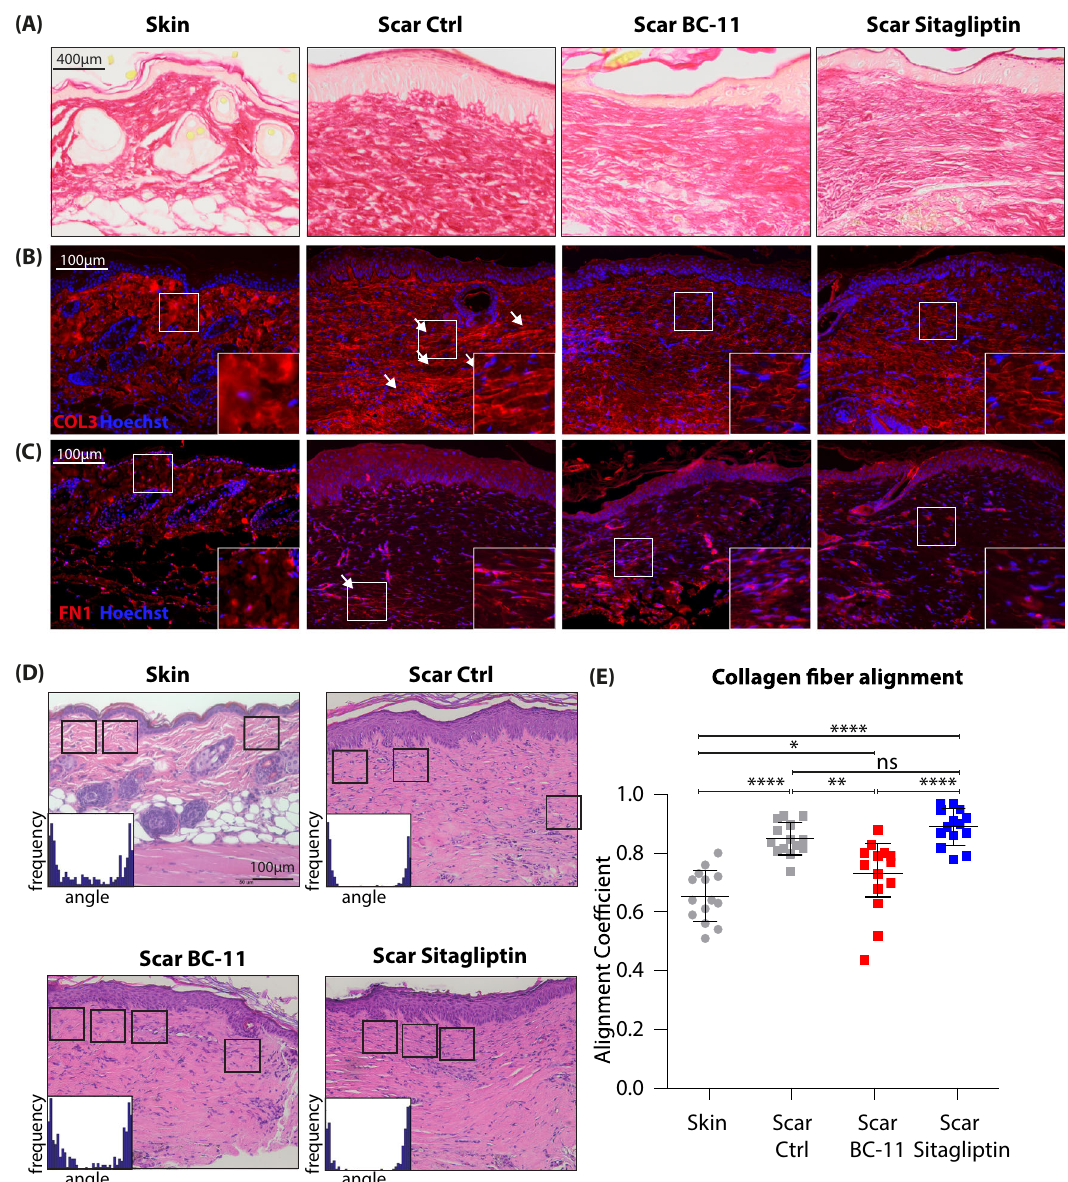
Fig. 9 In vivo application of BC-11 or Sitagliptin improves collagen alignment and fi ber orientation in mouse scars. A Picrosirius red staining and immuno fl uorescent staining of B Col3a1 and C fi bronectin in mouse skin and scars are shown. Four mice per group were analyzed. Arrows indicate areas of increased matrix density. D H&E images of mouse skin and scars. Squares indicate areas analyzed for collagen alignment. Histograms illustrate measurement of fi ber orientation. E Calculation of alignment coef fi cient by CurveAlign in mouse skin and scar. N = 4 mice were analyzed per group, and three to four Regions of interest were calculated per image. Whiskers represent range maximum and minimum values with <1.5 interquartile range, boxes represent 25th – 75th quartiles, line represents mean. Statistical signi fi cance was tested using one-way ANOVA with Tukey post-test. Skin vs Scar untreated p < 0.0001; Scar untreated vs Scar + BC-11 p = 0.0018; Scar untreated vs Scar + Sitagliptin p = 0.551. This mouse experiment was performed once, repetition of the experiment was not permitted by the ethics committee. NS p > 0.05, * p < 0.05, ** p < 0.01, *** p < 0.001. Source data are provided as a Source data fi RNAscope 2.5 HD Assay — RED as suggested by the manufacturer. Images were acquired by AX70 microscope (Olympus, Tokyo, Japan) using the imaging soft- ware MetaMorph (Olympus).